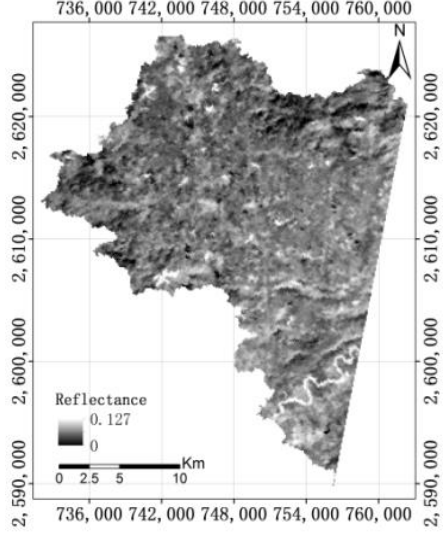
Figure 10. Spectral reflectance of soil at band 848 nm of HJ-1A HIS image.